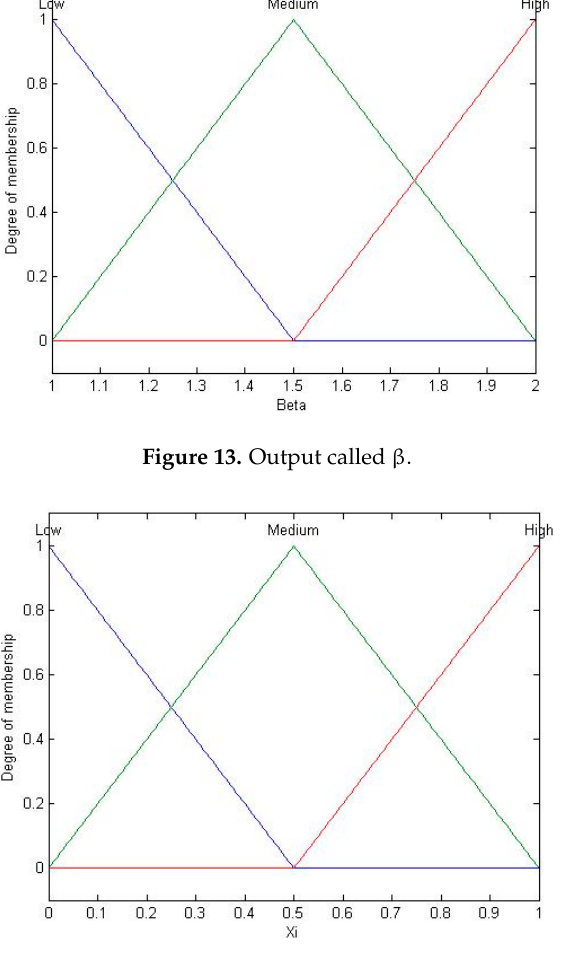
Figure 14. Output called ξ .